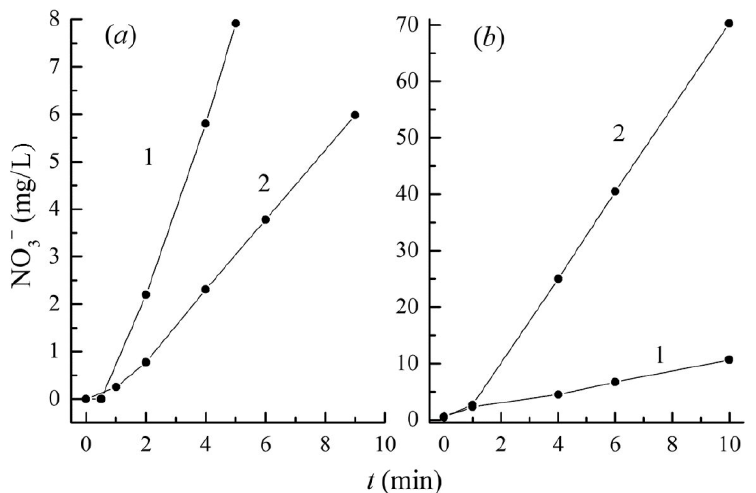
Figure 3. Time behavior of a specific amount of nitrate ions in distilled ( a ) and ground ( b ) water: barrier discharge (1); bubble discharge (2).